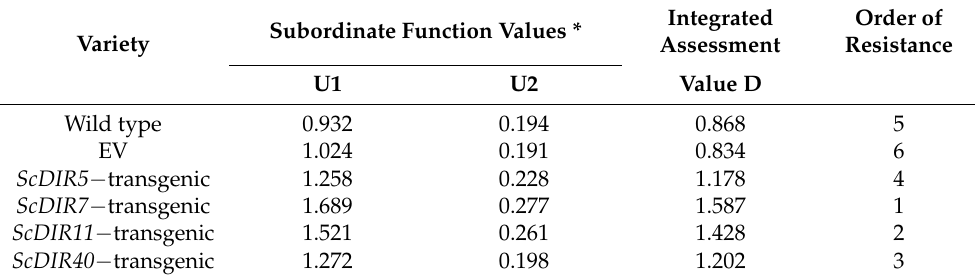
Table 1. Subordinate function values of principal components and comprehensive evaluation of drought tolerance in transgenic n. benthamiana . Integrated Order of Subordinate Function Values * Variety Assessment Resistance U1 U2 Value D Wild type 0.932 0.194 0.868 5 EV 1.024 0.191 0.834 6 ScDIR5 − transgenic 1.258 ScDIR11 − transgenic ScDIR40 − transgenic